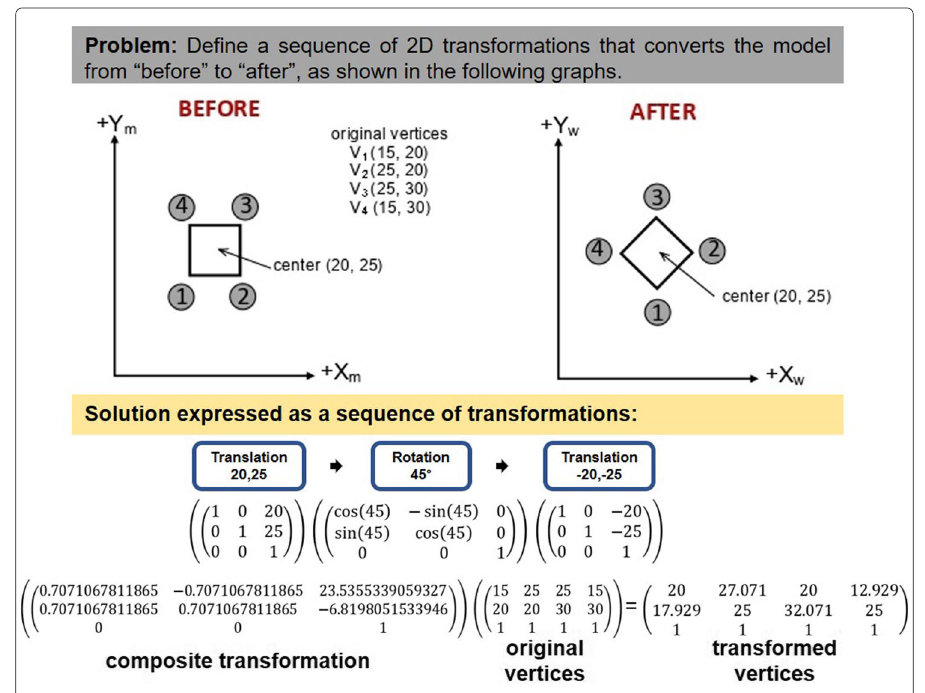
Fig. 5 Example: class assignment of simple sequence of 2D transformations